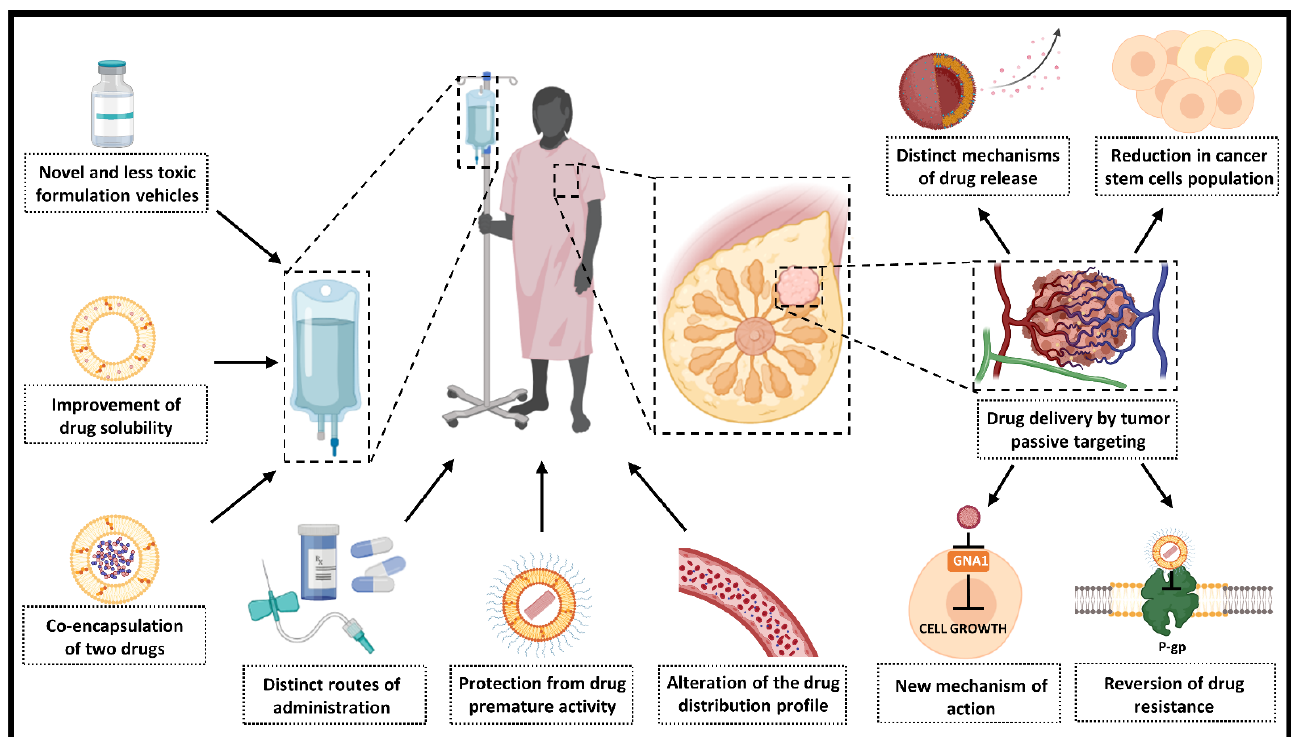
Figure 4. Some contributions of nanotechnology for cancer treatment. This illustration summarizes the contributions from the formulation step to the tumor cells and higher efficacy. Thus, this highlights that nanotechnology is more than just formulation and investments in this strategy for drug delivery are worth it (Pgp: P-glycoprotein) (Created with BioRender.com).